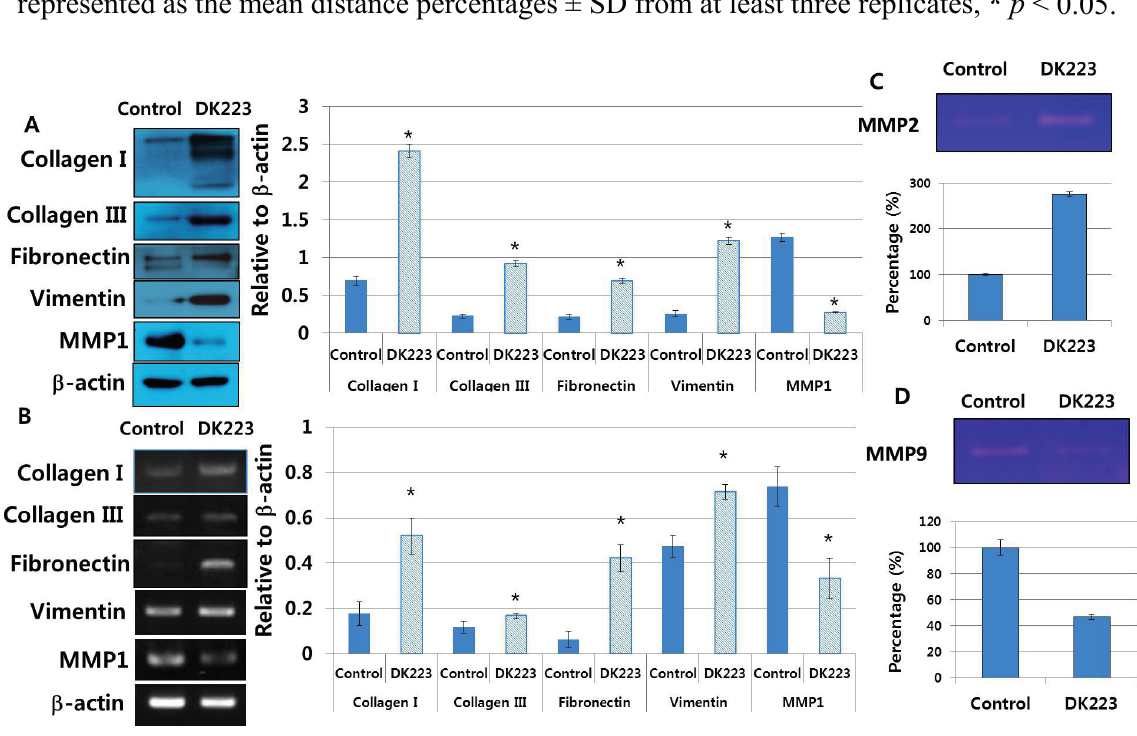
Figure 6. Expression of extracellular matrix proteins and metalloproteinase genes. ( A ) Dermal fibroblasts were treated with 2 μ M DK223 in serum-free media.